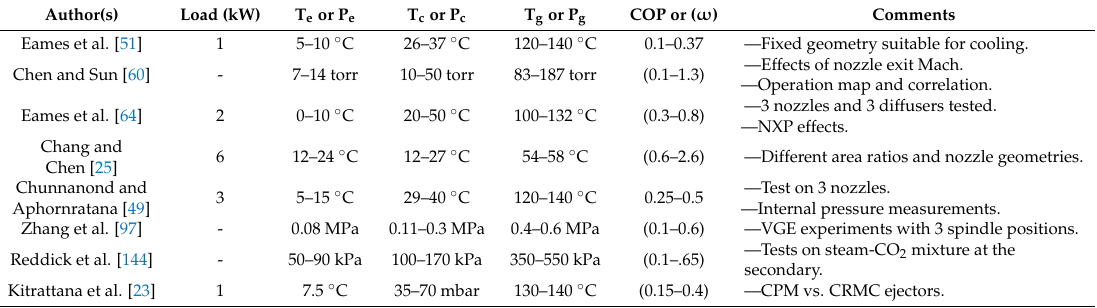
Table 4. Experiments with steam.